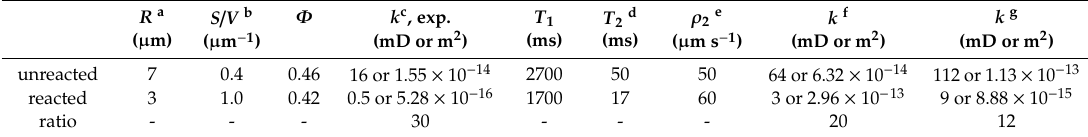
a radius of an equivalent sphere from SEM image analysis from Figure 2. b assuming a spherical equivalent pore, S/V = 3/R. c experimentally, from Fig. 4c, 1 mD = 10 − 16 m 2 . d from Fig. 5d by extrapolation